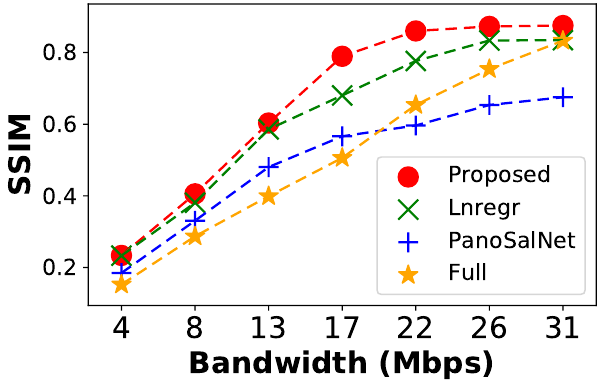
Figure 8. Viewport Perceived Quality under different bandwidth